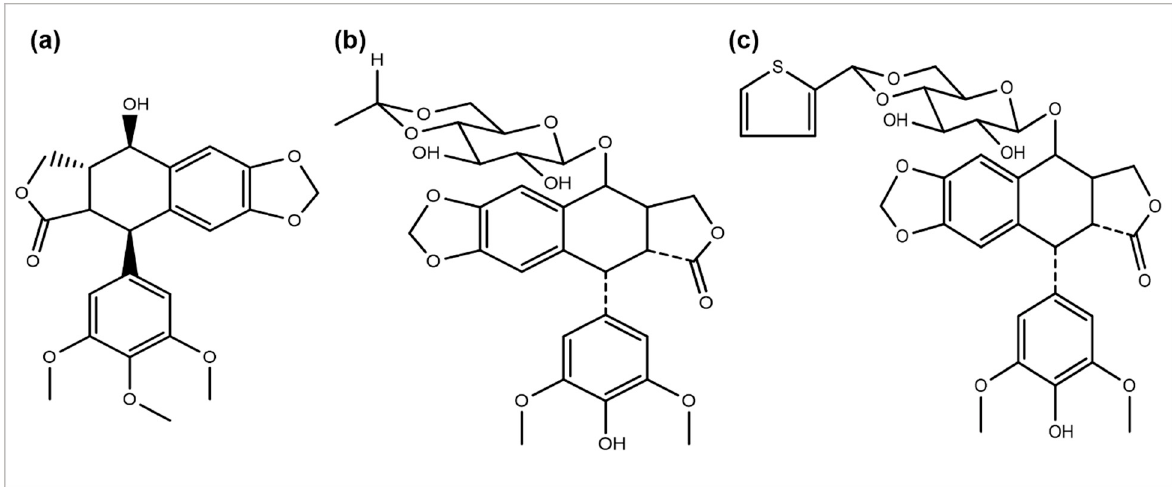
Figure 4. Chemical structures of ( a ) podophyllotoxin, ( b ) etoposide, and ( c ) teniposide.